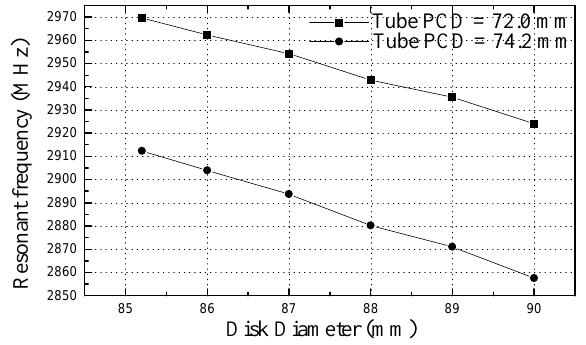
FIG. 4. Effect of the the disks outer diameter on the resonant frequency of the PWT linac structure.